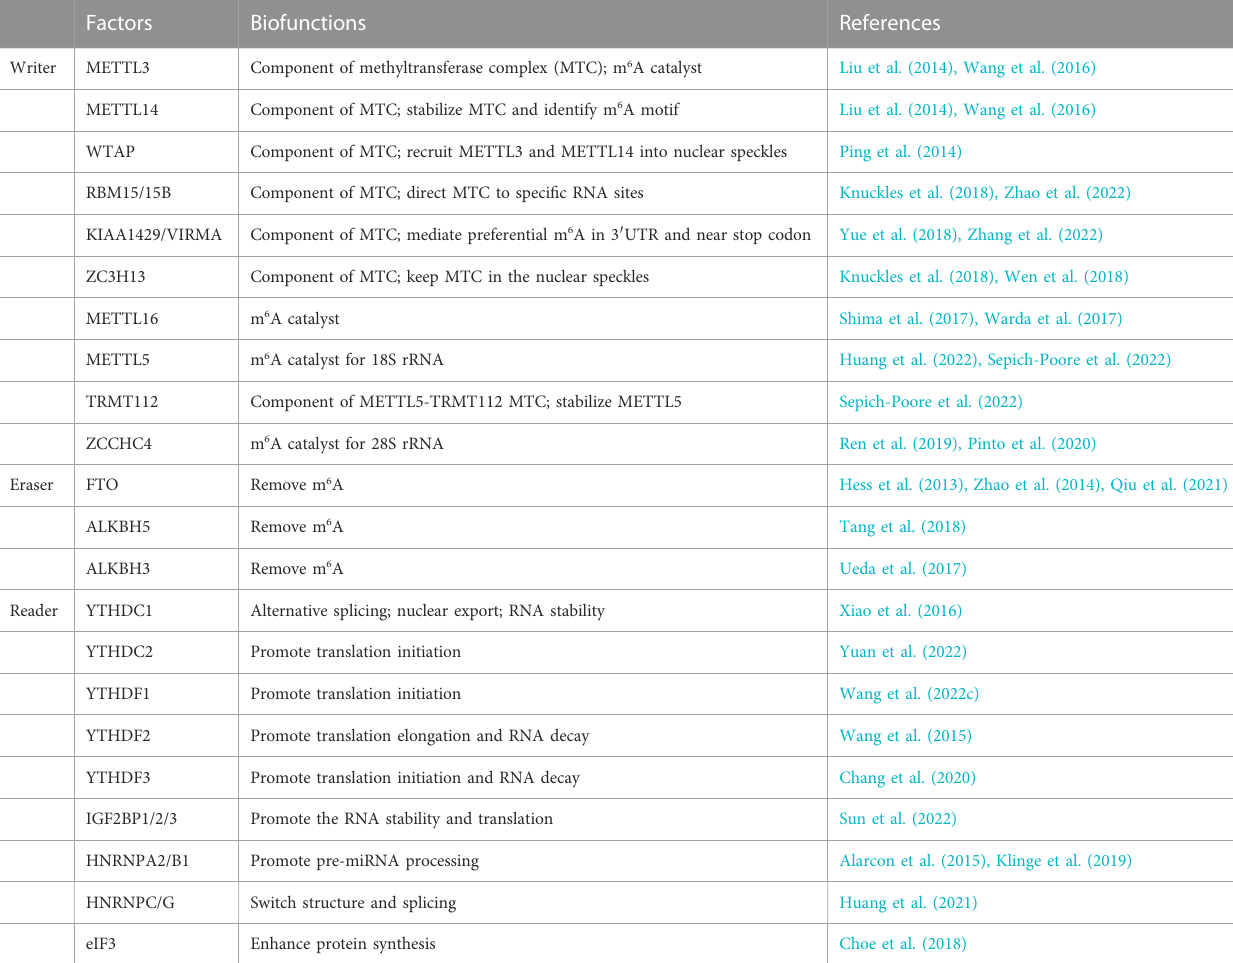
TABLE 1 The biofunctions of m 6 A key enzymes in RNA metabolism.